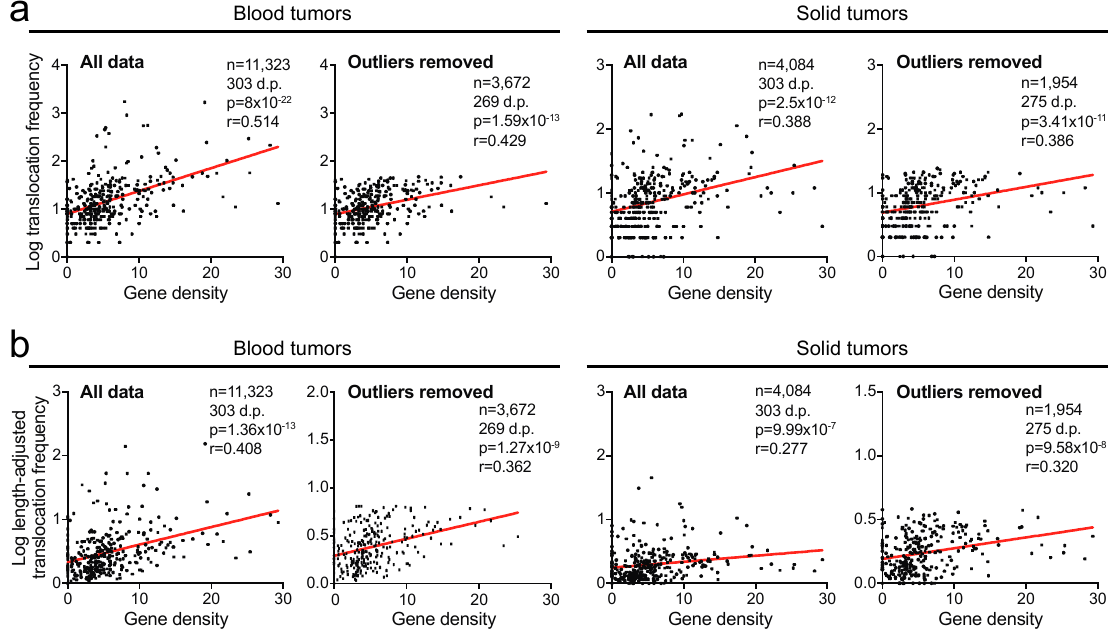
Figure 4. Translocation breakpoints preferentially occur in gene-rich regions. ( a ) Scatter plots of gene densities in cytogenetic chromosome bands correlated with translocation frequencies within these bands in blood and solid tumors. ( b ) Scatter plots of gene densities in cytogenetic chromosome bands correlated with length-adjusted translocation frequencies in blood and solid tumors. D.p., data points. Statistics: see Figure 1.